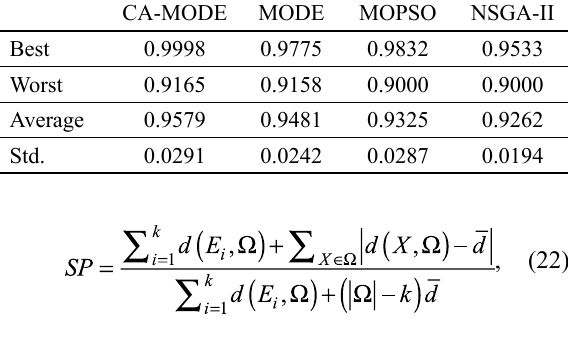
Table 7. Comparison of HV-metric for different algorithms